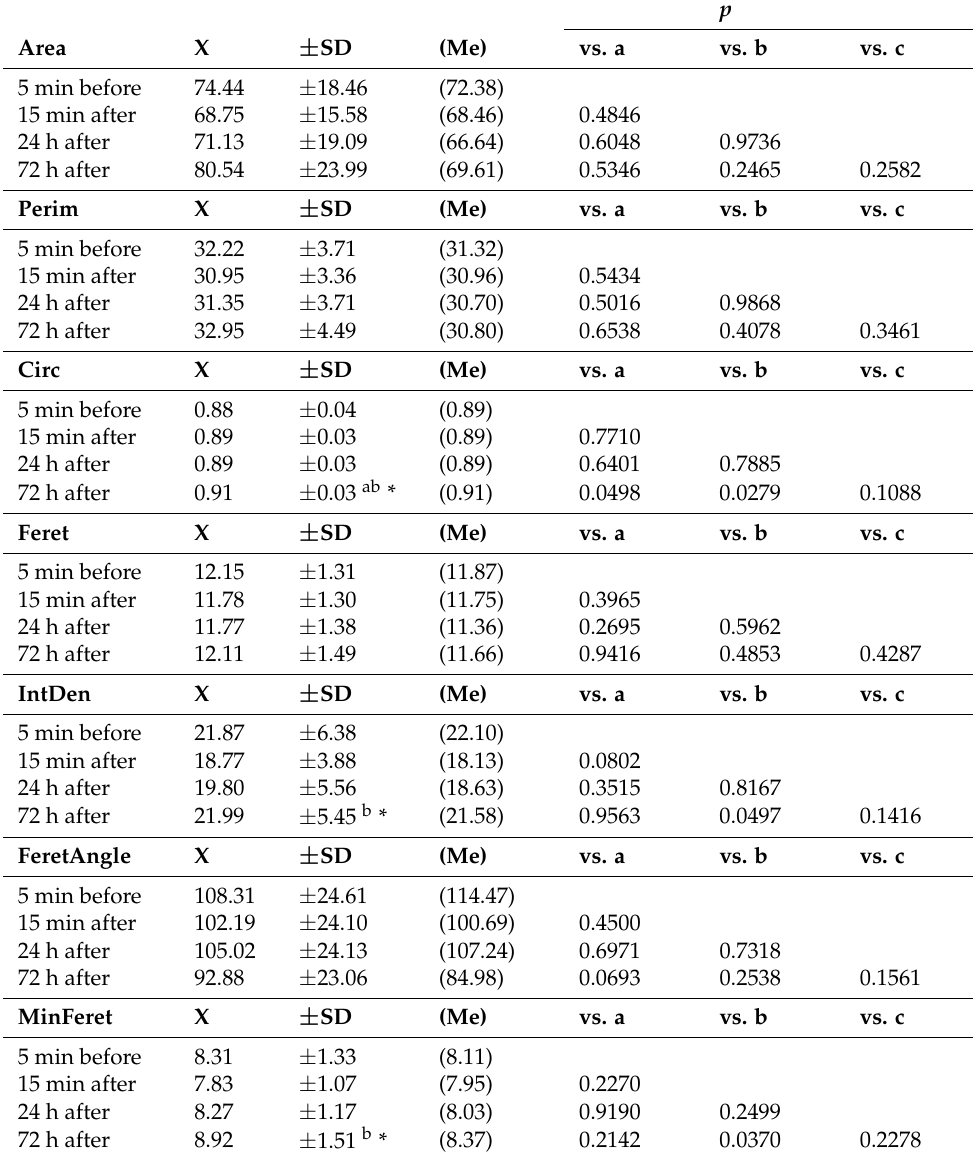
Table 2. Cytological values during the